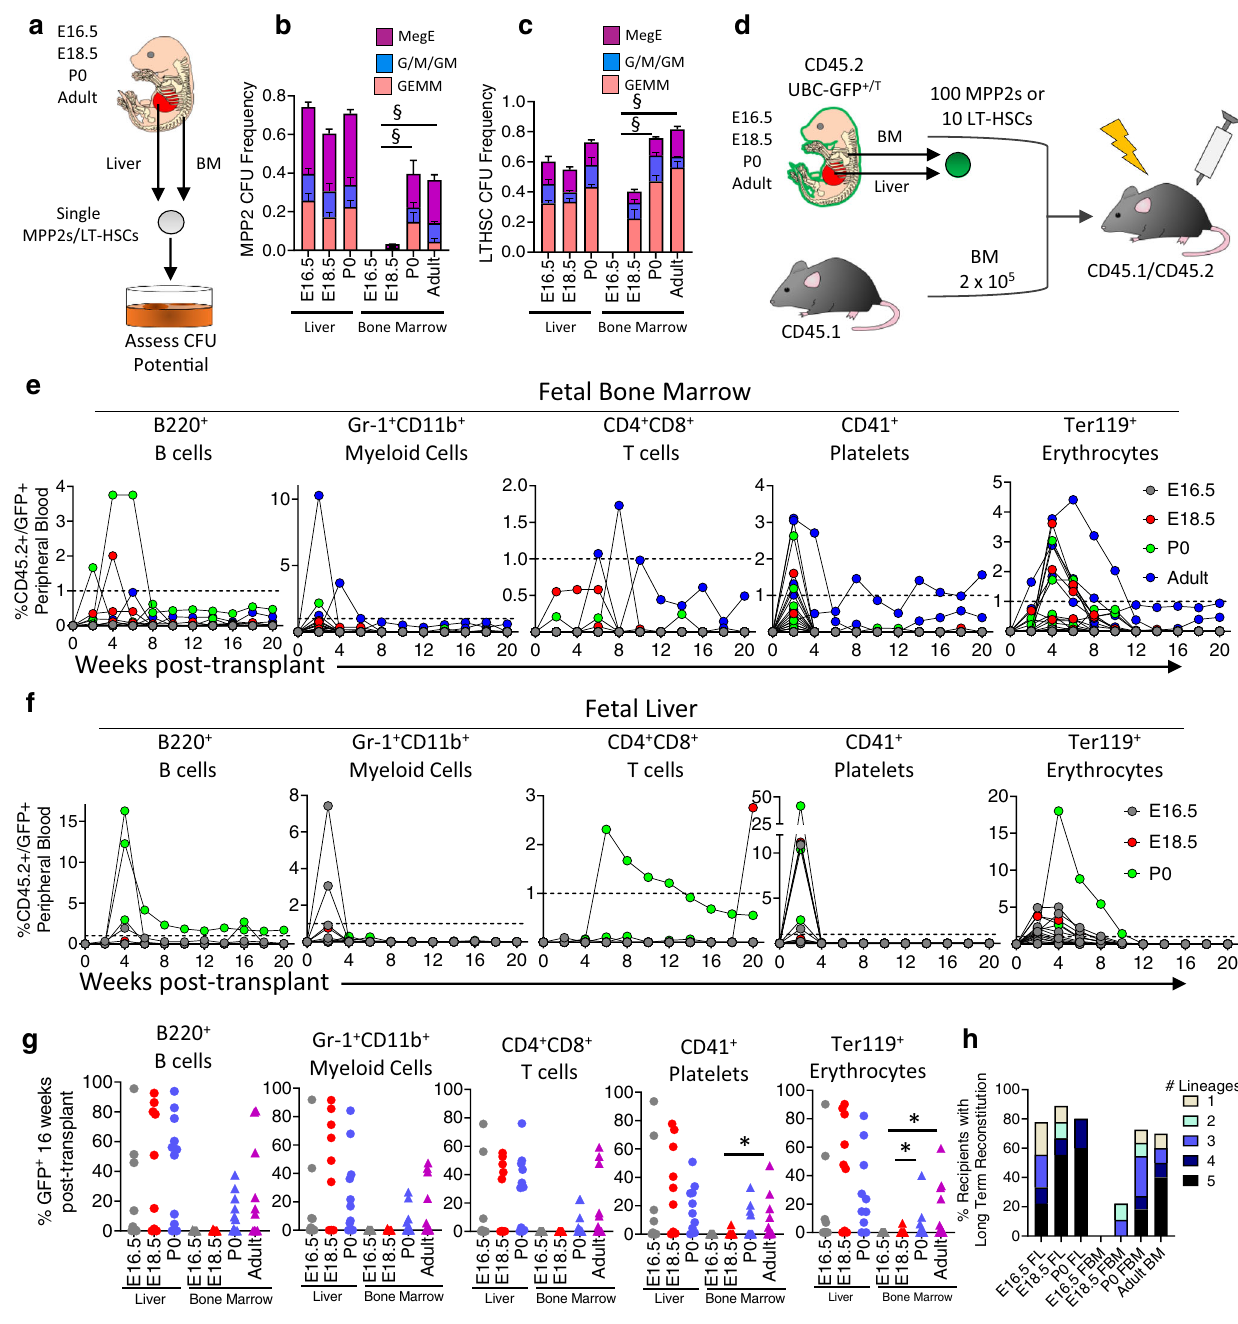
Fig.3|FBMMPP2sarefunctionallydistinctfromFLandadultBMMPP2s.a CFU assay of single MPP2 and LT-HSC cells. b BM and liver MPP2 CFUs frequency.